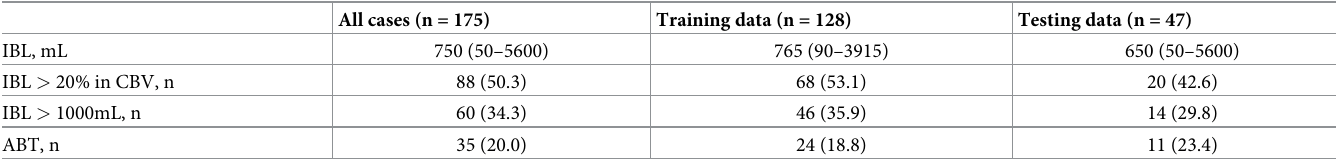
Table 2. Information of IBL.